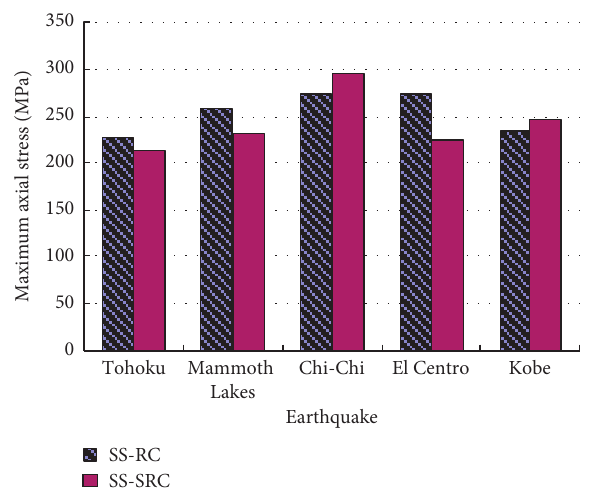
Figure 17: Maximum axial stresses of the latticed shell members.